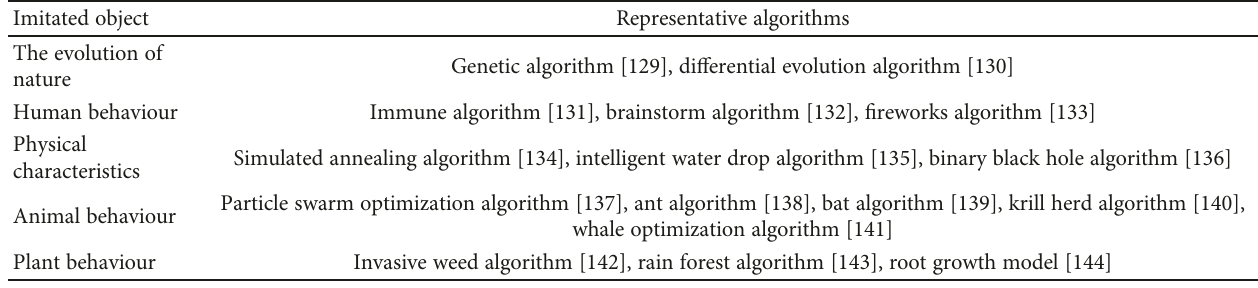
Table 2: Some of the metaheuristic optimization algorithms.